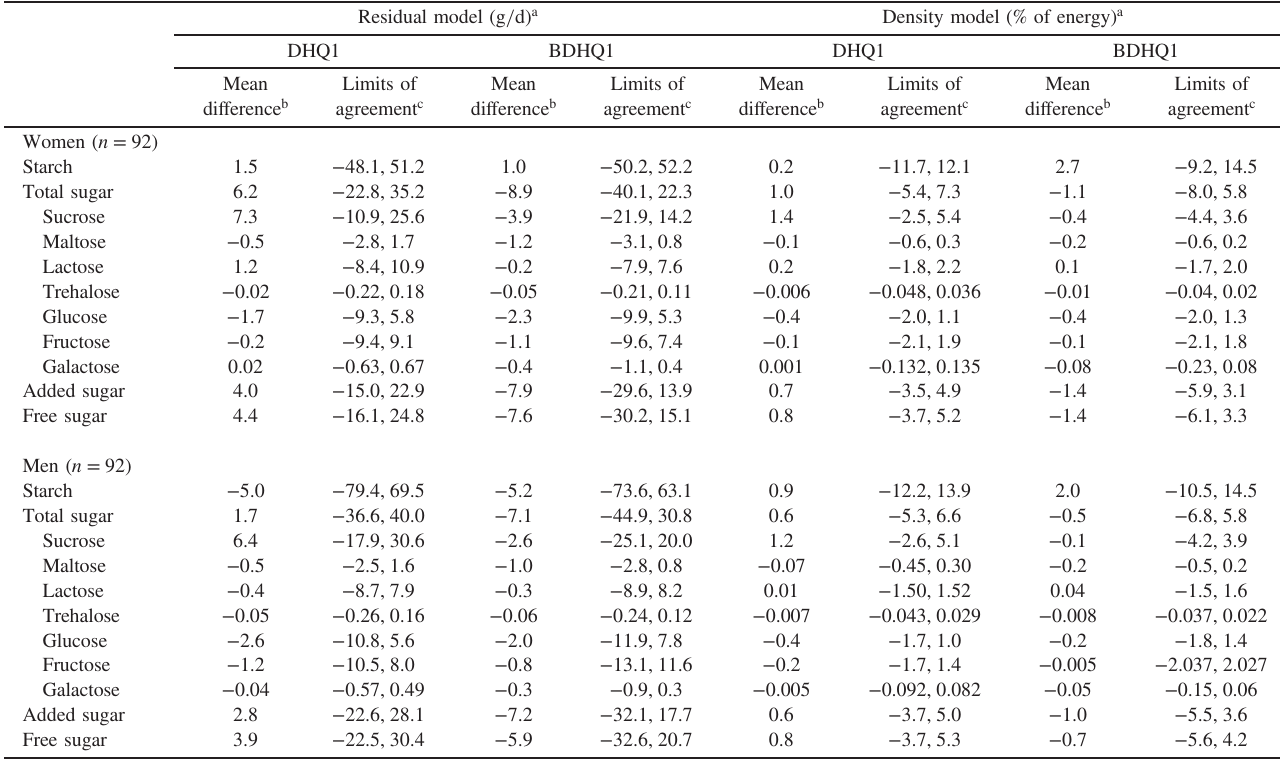
Table 5. Brand-Altman statistics between intake of starch and 10 types of sugars estimated using the 16-day DRs and that estimated using the DHQ1 and BDHQ1 among Japanese women and